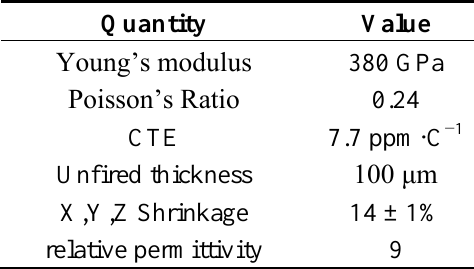
Table 3. Characteristics of HTCC